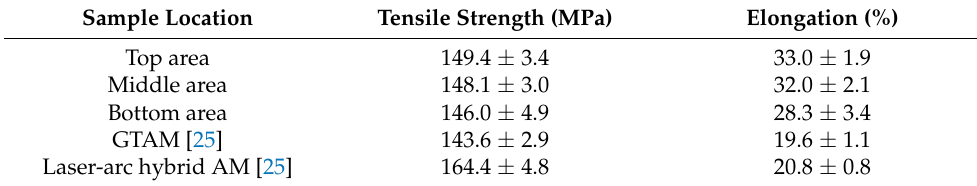
Table 3. Tensile results of 4043 aluminum alloy formed parts at different heights in the horizontal